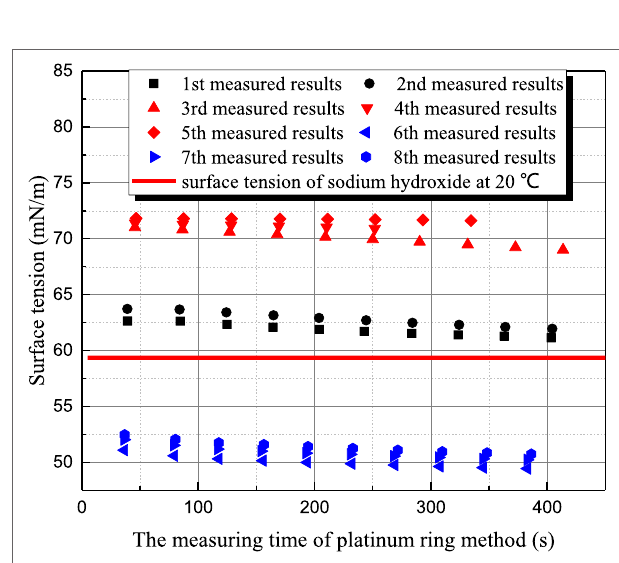
FigUre 5 | The history of measured surface tension of sodium thiosulfate by platinum ring method (sodium hydroxide concentration is 1 mol/L; solution temperature is 35°C).